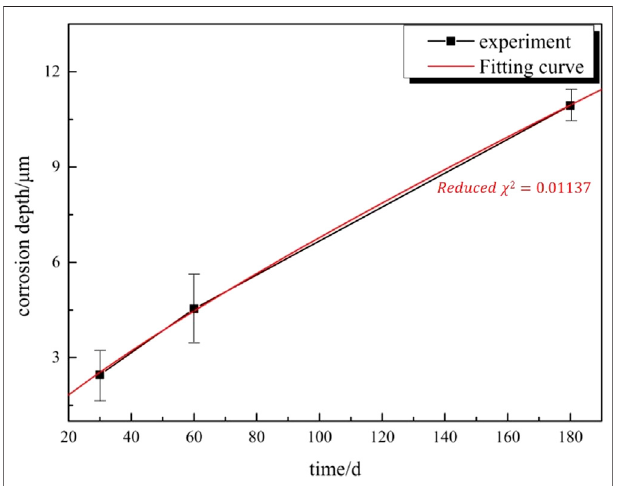
FIGURE 11 | XRD analysis of corrosion